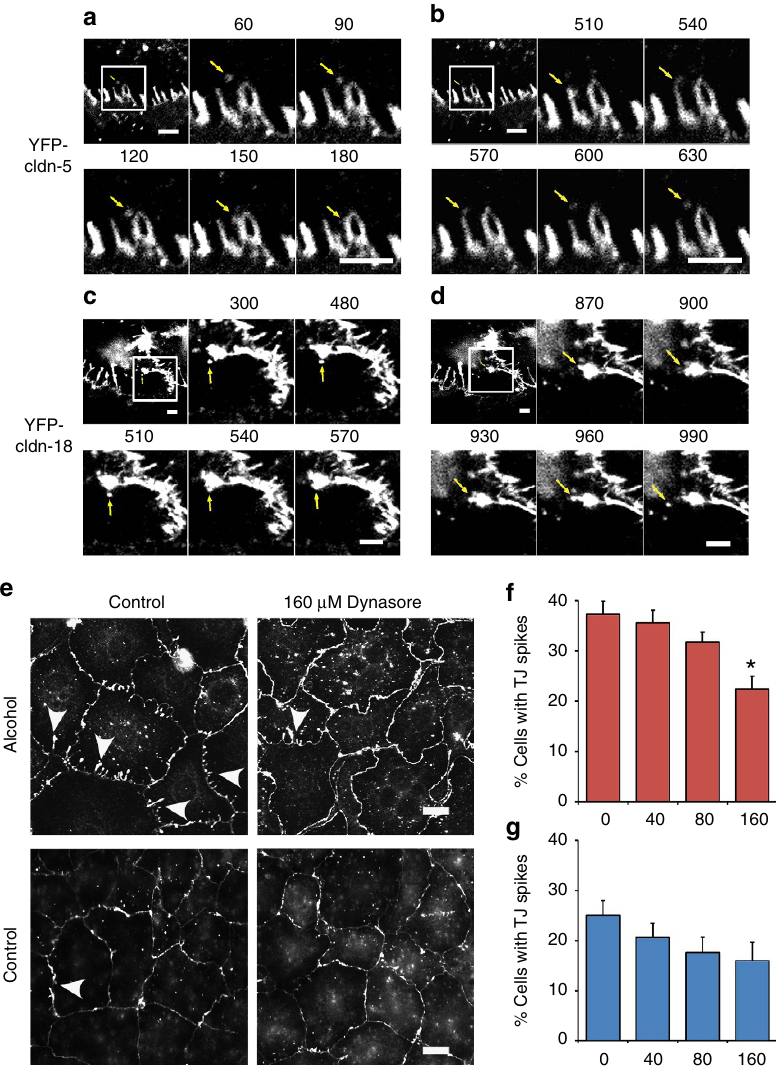
Figure 3 | Claudin-containing vesicles bud from and fuse with tight junction spikes. ( a – d ) Live cell imaging was performed with alcohol exposed AECs transduced with Adenovirus encoding either YFP-claudin-5 ( a , b ) or YFP-claudin-18 ( c , d ). Shown are still images from videos acquired over a 20min time period with a frame capture of 30s intervals. Labeled vesicles containing YFP-claudin-5 or YFP-claudin-18 were found to both fuse to ( a , c ) and bud from ( b , d ) tight junction spikes, demonstrating that these are dynamic structures. The top left panel in each series is a lower magnification image, the square region represents the time series, which is time stamped in seconds. Bar, 5 m m. ( e ) Cells from alcohol fed or control fed rats were cultured for 7 days and then treated with either DMSO vehicle control or the dynamin inhibitor Dynasore at varying concentrations for 4h at 37 (cid:2) C in serum free media. The cells were then fixed and immunolabeled for claudin-18. Representative images show vehicle-treated and 160 m M Dynasore treated cells. Arrowheads show tight junction spikes. Bar, 10 m m. ( f , g ) Quantification of the % cells containing 3 or more tight junction spikes oriented towards the nucleus demonstrated that 160 m M Dynasore significantly decreased the number of cells from alcohol fed rats containing spikes ( n ¼ 8-9 fields, * P ¼ 0.002, one way ANOVA with Tukey multiple comparisons test) ( f ). Dynasore did not have a significant effect on spike formation by control cells ( g ). All quantitative data represents average ±